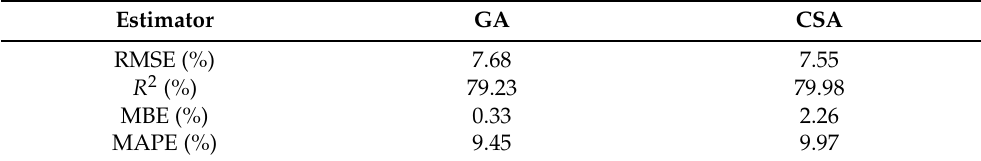
Table 5. Statistical errors of the models obtained by the GA and CSA.